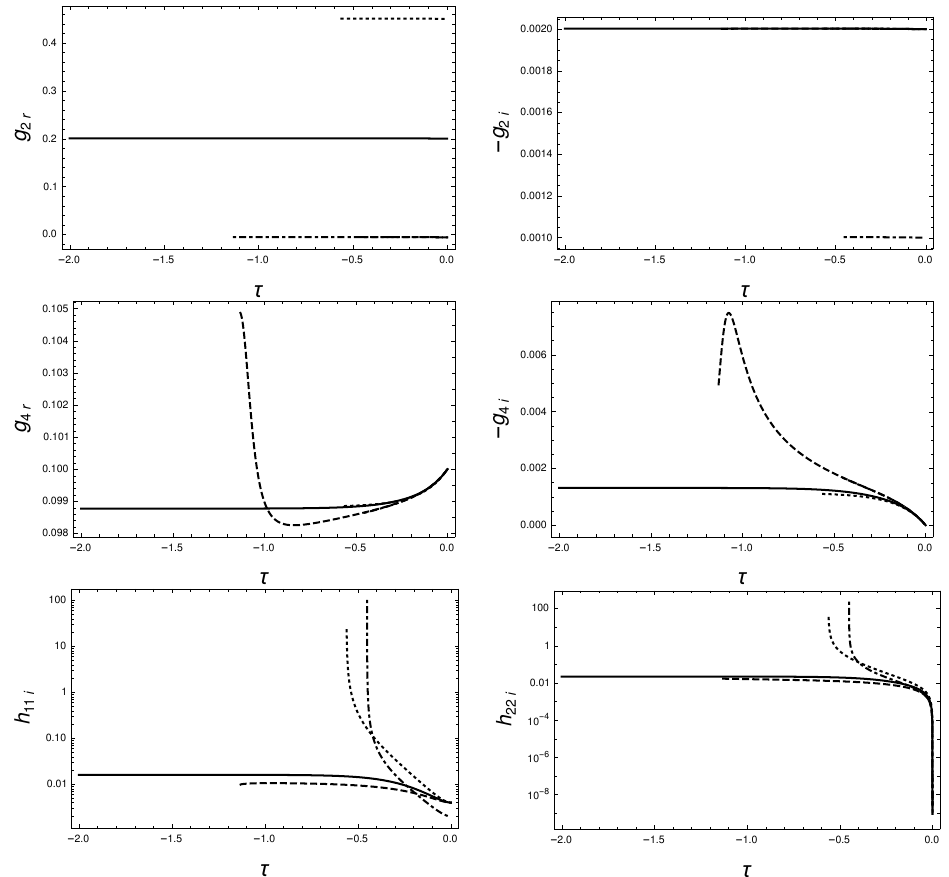
Figure 6. Typical trajectories at g 4 ( Λ ) = 0.1, h 11 ( Λ ) = − i 2 g 2 i ( Λ ) , h 22 ( Λ ) = 0 in the phases S ( g 2 ( Λ ) = 0.2 − i 0.002, continuous line), SB ( g 2 ( Λ ) = − 0.006 − i 0.002, dashed line), S E ( g 2 ( Λ ) = 0.45 − i 0.002, dotted line) and SB E ( g 2 ( Λ ) = − 0.006 − i 0.001, dashed-dotted line), η =